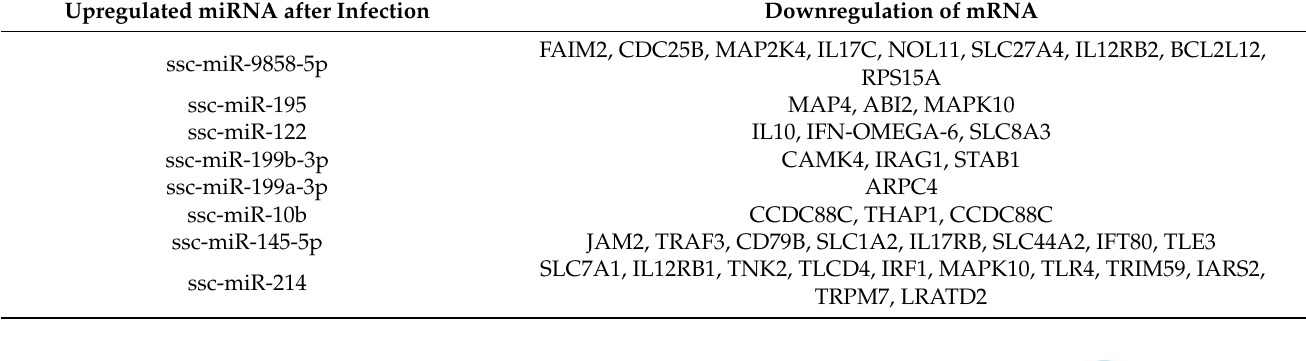
Table 5. Target genes corresponding to the upregulated miRNA after infection.